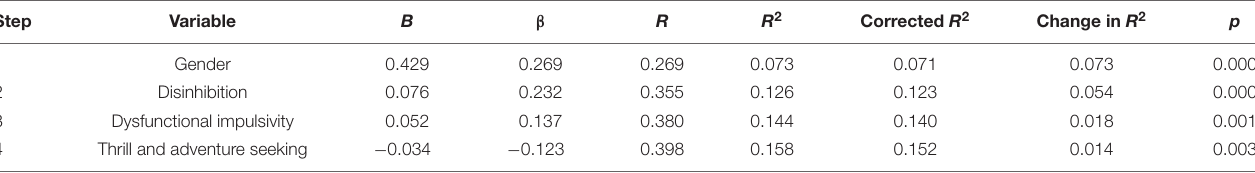
TABLE 1 | Results of the stepwise regression analysis for smartphone abuse.